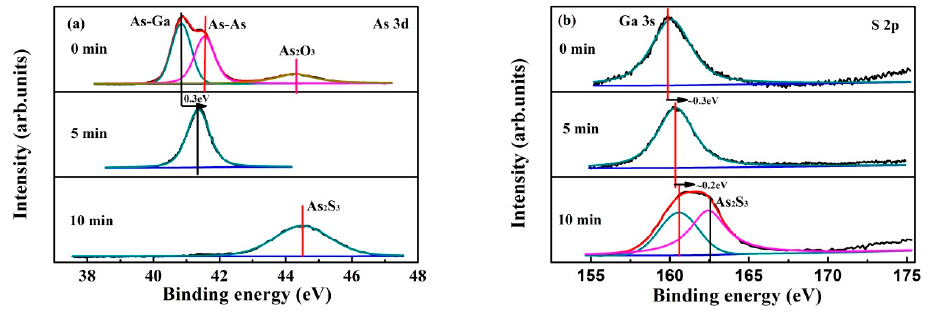
Figure 5. X-ray photoelectron spectroscopy (XPS) analysis of the GaAs surface using different SF 6 plasma treatment for 0 min, 5 min, and 10 min, ( a ) As 3d and ( b ) S 2p.